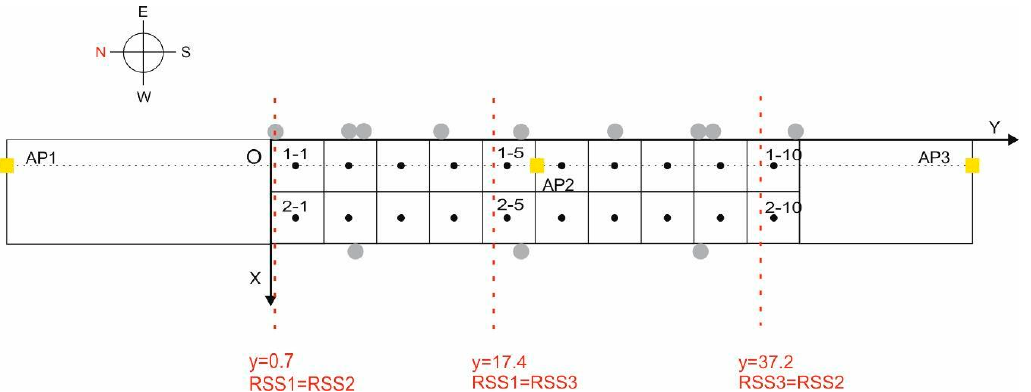
Figure 10. Straight lines with equal RSS values for Wi-Fi access point pairs.